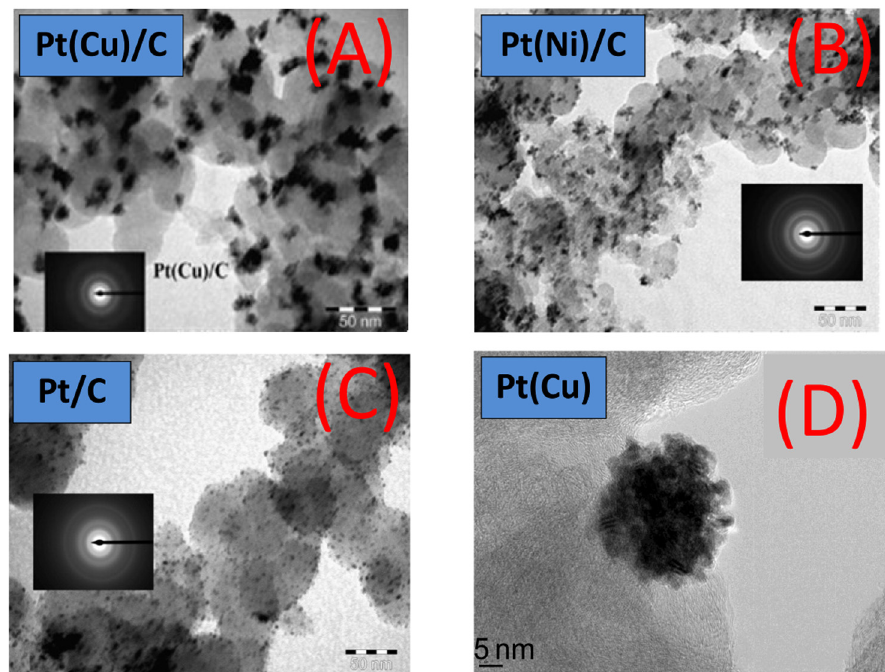
Figure 7. Transmission electron microscopy (TEM) micrographs of supported and